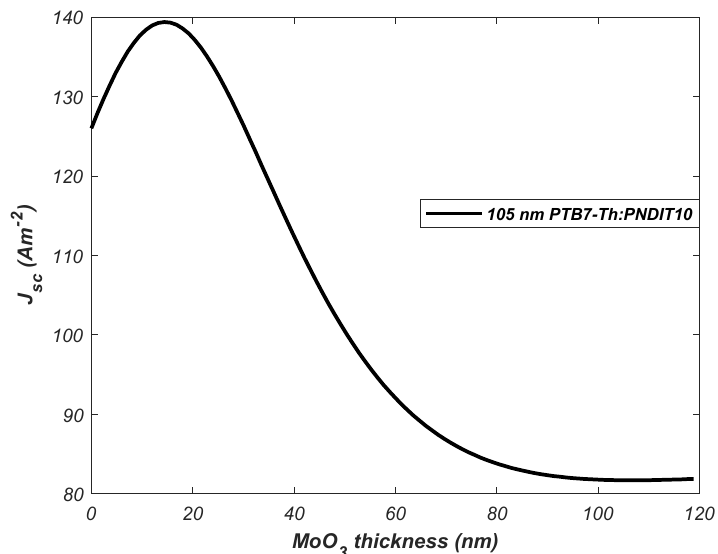
Figure 5. J SC of inverted OSC plotted as a function of the MoO 3 layer at an active layer thickness of 105 nm and Al layer thickness of 1 nm. Table 2. Summary of the optimized components of the inverted and conventional OSC.